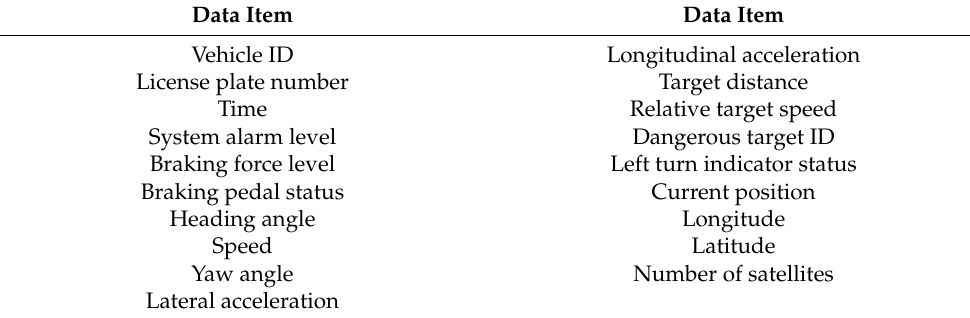
Table 1. Basic data of natural driving of